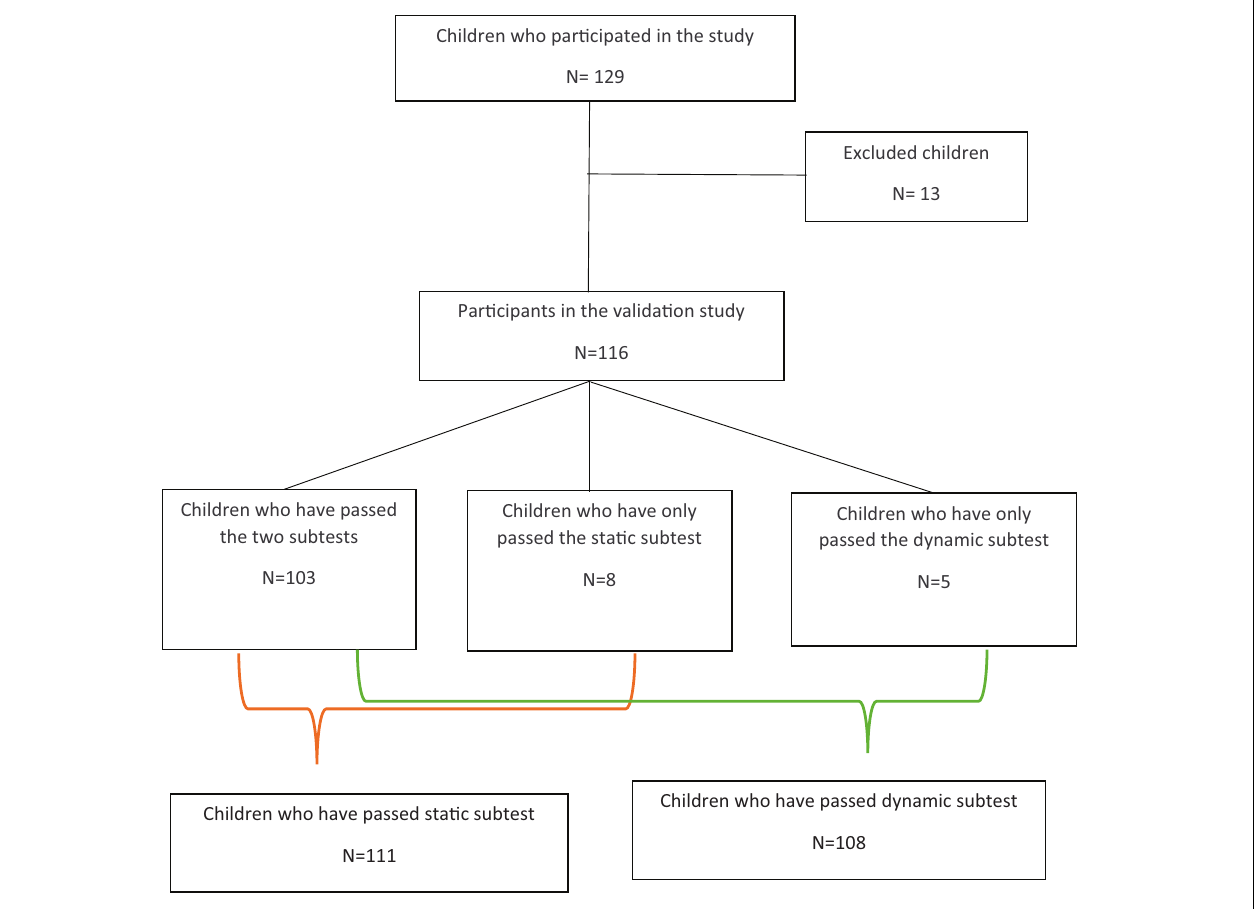
FIGURE 1 | The repartition of participants according to the subtest completed.